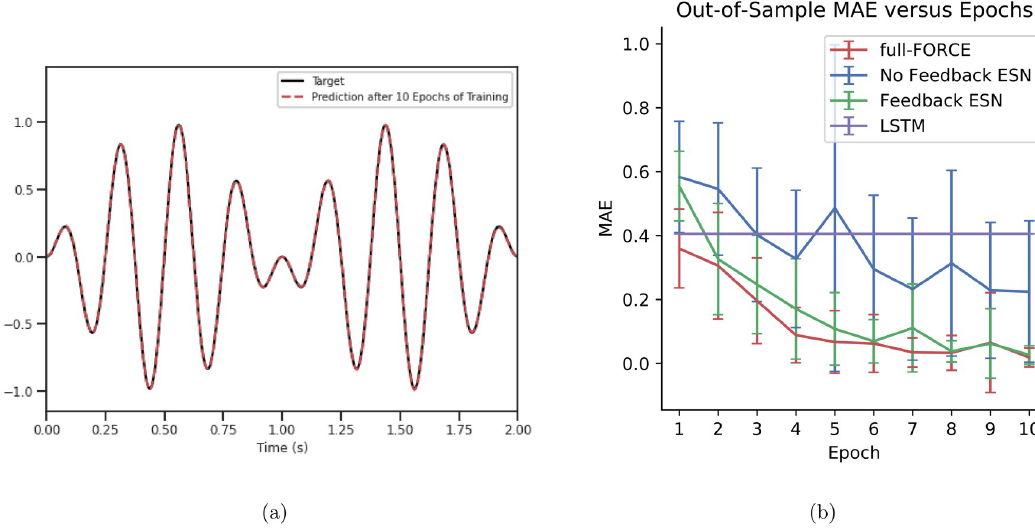
Fig 4. FORCE-training different network architectures to generate an autonomous periodic function. (A) Target output and full-FORCE output after 10 epochs using 400 fully connected neurons. (B) MAE comparison of different FORCELayers and standard LSTM trained by BPTT with